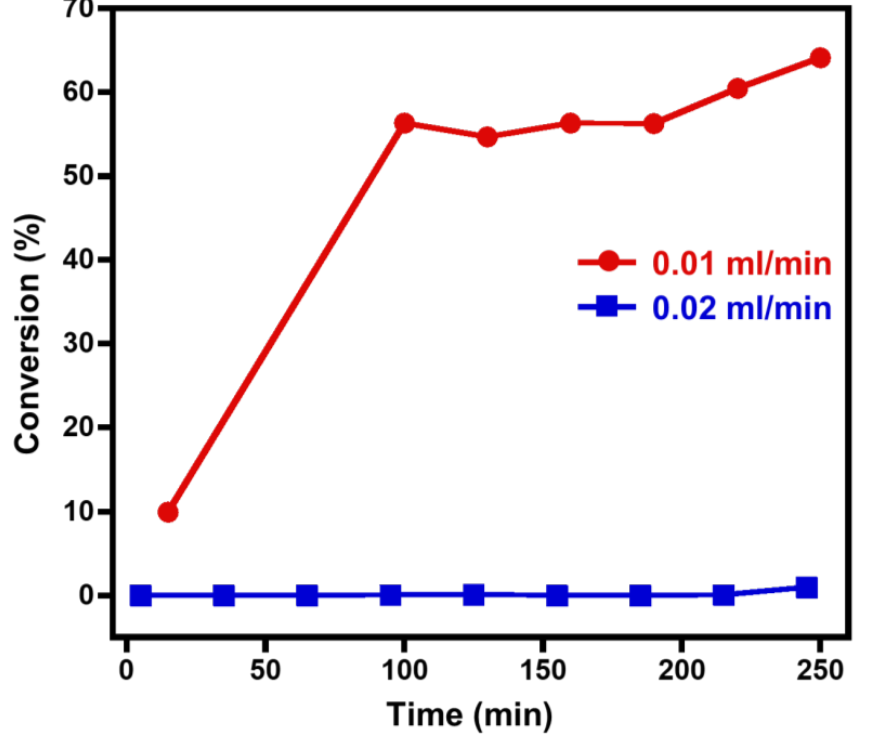
Figure 9. Effect of toluene flow rate on catalytic performance (conditions: catalyst amount: 0.3 g; calcination temperature: 450 °C; reaction temperature: 250 °C).